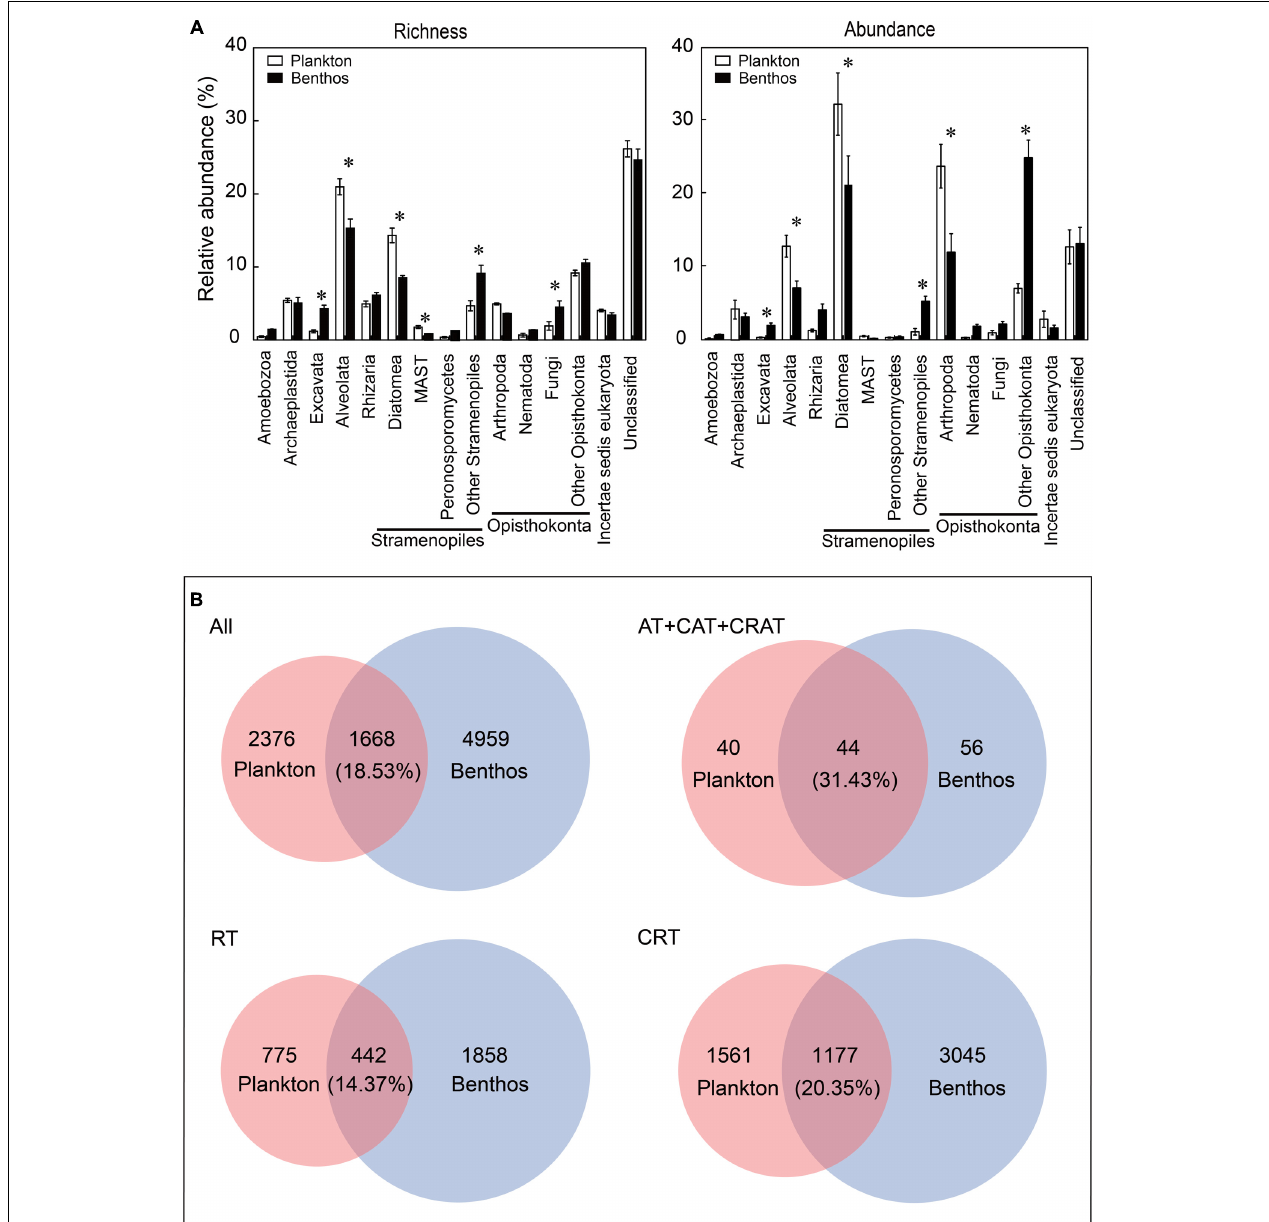
FIGURE 2 | Comparison of microeukaryotic community between planktonic and benthic taxa at supergroup and OTU levels. (A) Relative abundance of richness (OTU numbers) and abundance (sequence numbers) of planktonic microeukaryotic taxa compared with benthic microeukaryotic taxa. Unclassified eukaryotes (sequence similarity > 80%). Values are means ± SE ( n = 12); ∗ P < 0.05 (Student’s t -test). (B) Venn diagrams showing the number and percentage of OTUs that are unique and shared between the microeukaryotic plankton and benthos. All, all taxa; AT, abundant taxa; CAT, conditionally abundant taxa; CRAT, conditionally